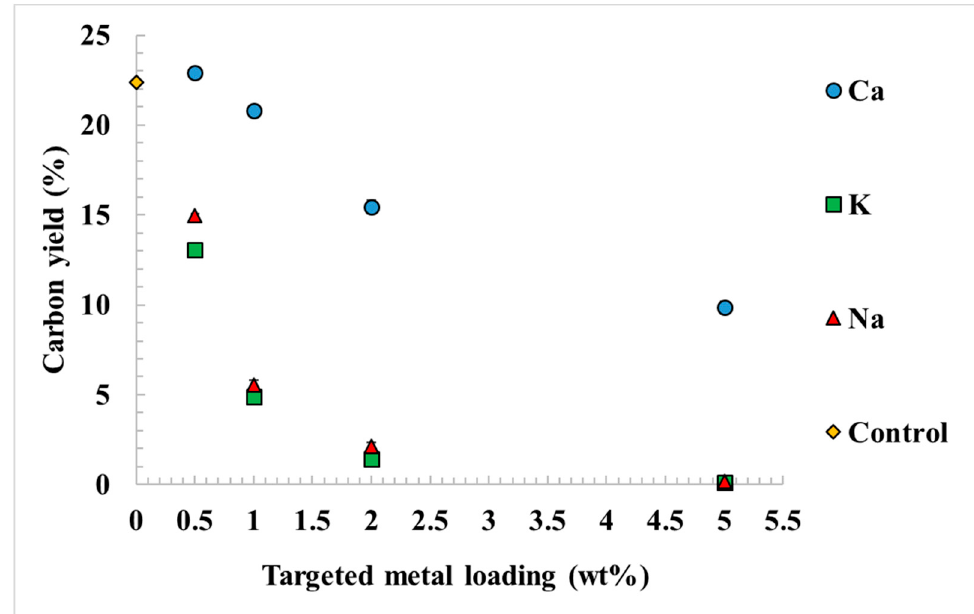
Figure 4. Aromatic hydrocarbons yield from in-situ CFP experiments with H + ZSM-5 catalysts deactivated by inorganics.